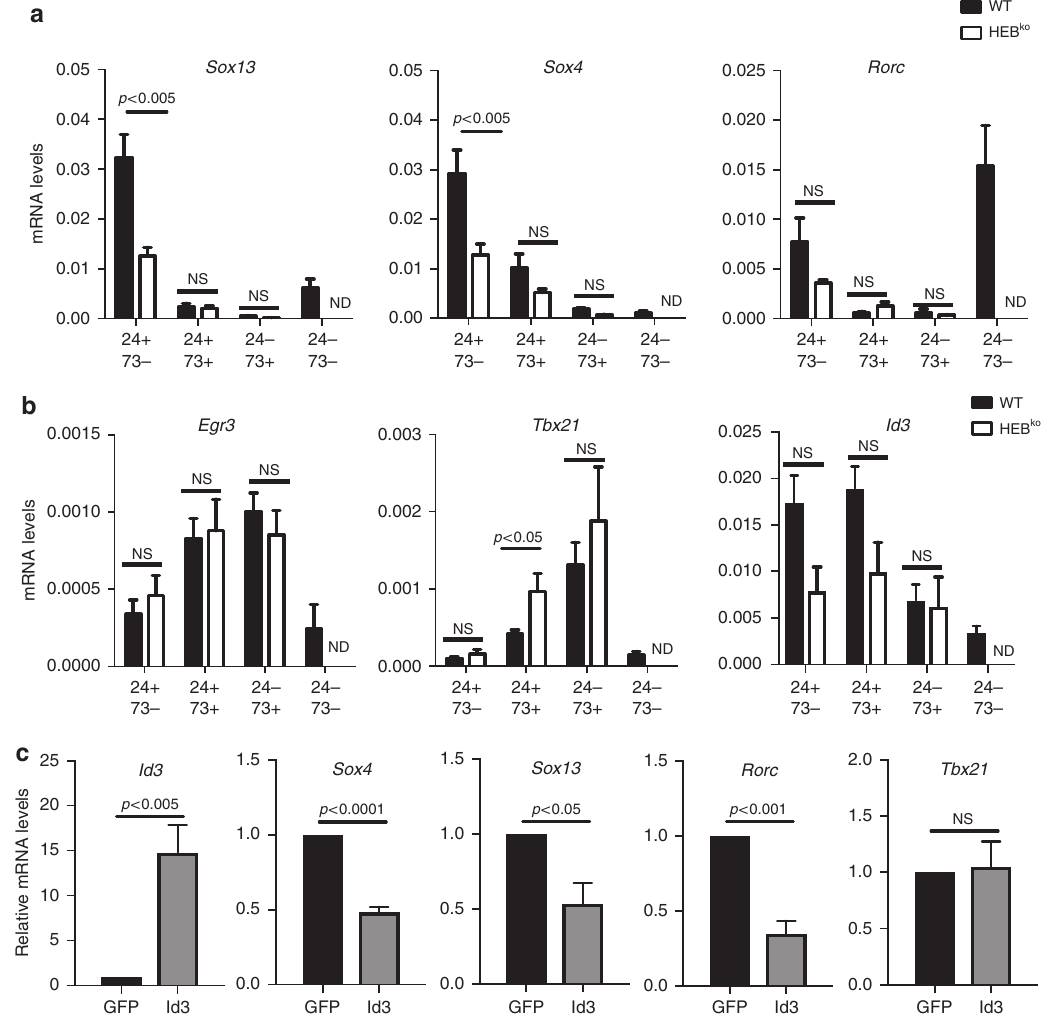
Fig. 5 Decreased levels of γδ T17 cell-related gene expression HEB ko γδ T cells. a , b qRT-PCR analysis of γδ T17 cell-related genes a and γδ T1 cell-related genes b in γδ T cell (CD3 + TCR γδ + ) subsets sorted based on the expression of CD24 and CD73 from WT and HEB ko FTOC day 7. Values are normalized to β -actin mRNA levels. Data are representative of at least three independent experiments with at least 3 mice per group. c qRT-PCR analysis of Id3 , Sox4 , and Sox13 mRNA expression in CD24 + CD73 − γδ T cells sorted from d3 FTOC-derived thymocytes that had been transduced overnight with GFP only, or GFP and Id3. Relative mRNA levels were calculated as the expression fold change over the GFP control. Data are representative of two independent experiments with 2 samples per group. Center values indicate mean, error bars denote s.e.m. p -values were determined by two tailed Student's t- test. ND = not done due to low cell number. NS = not signi fi